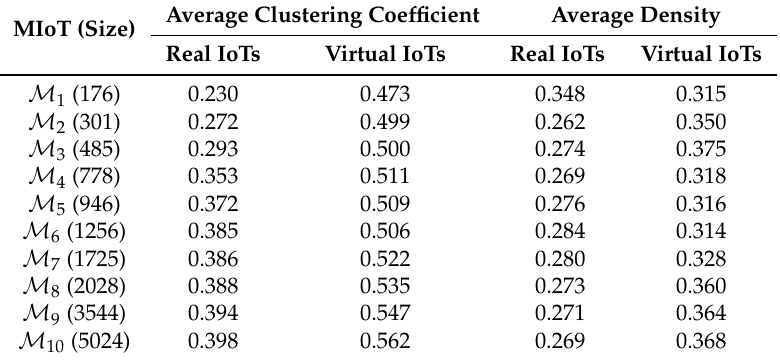
Table 4. Values of both clustering coefficient and density of real and virtual IoTs against the size of MIoTs (unsupervised